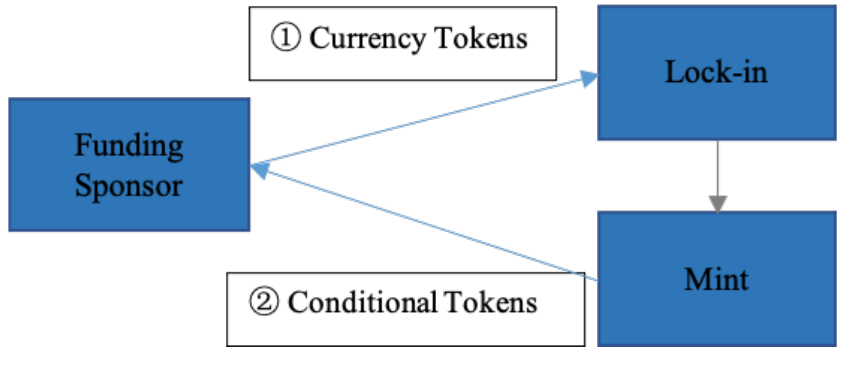
Figure 3. Right-type